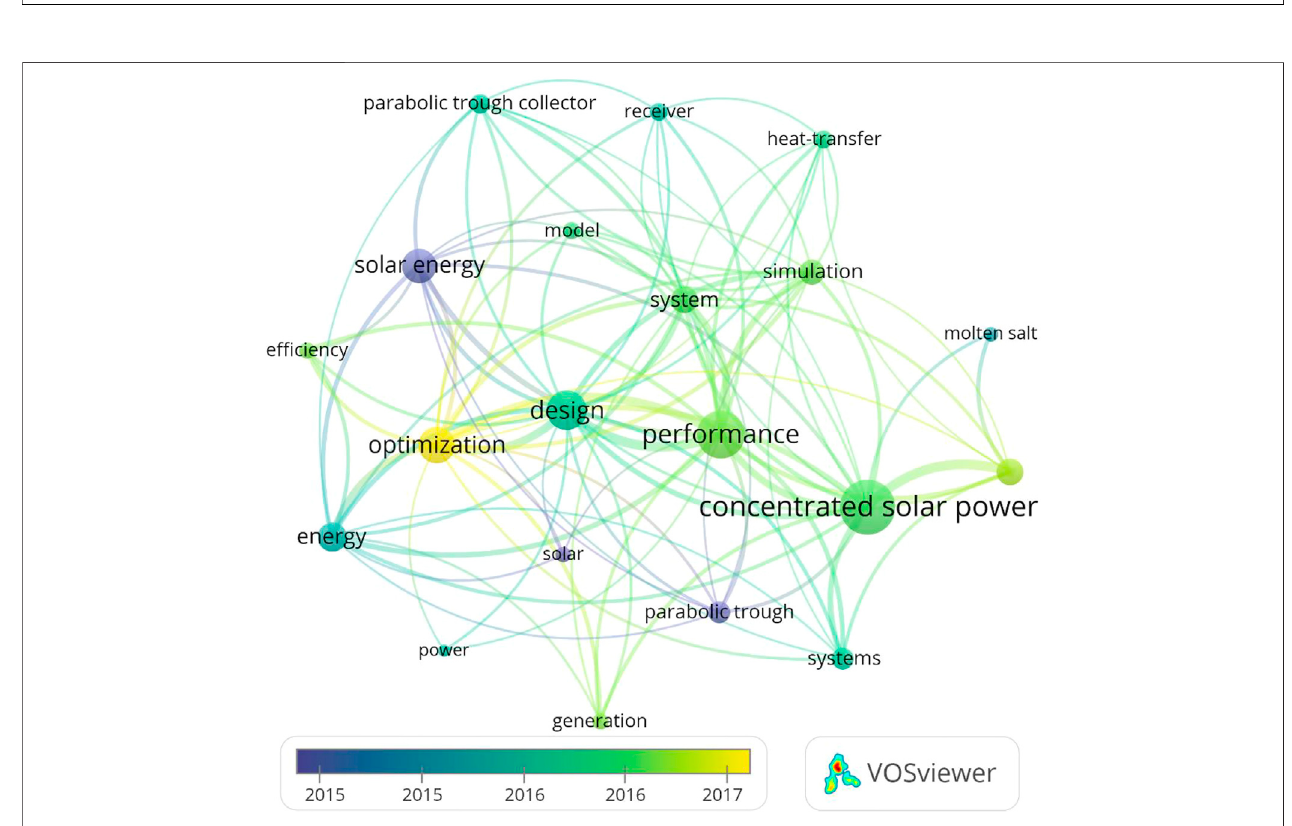
FIGURE 2 | Evolution of trend keywords on CSP